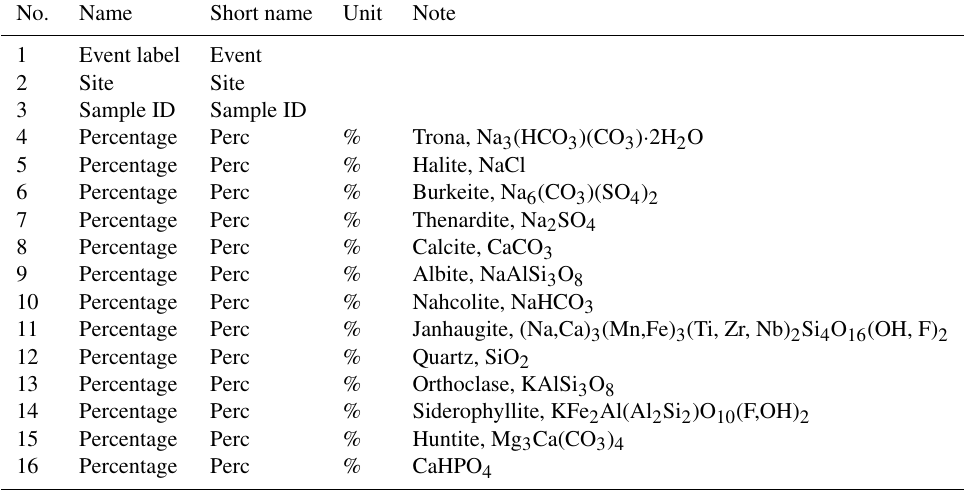
Table 6. Structure of the salt crust salt mineral characterisation via quantitative X-ray diffraction data set at PANGEA (Lasser and Karius, 2020). The data consist of site and sample IDs and the weight percentages of various salts within each sample.